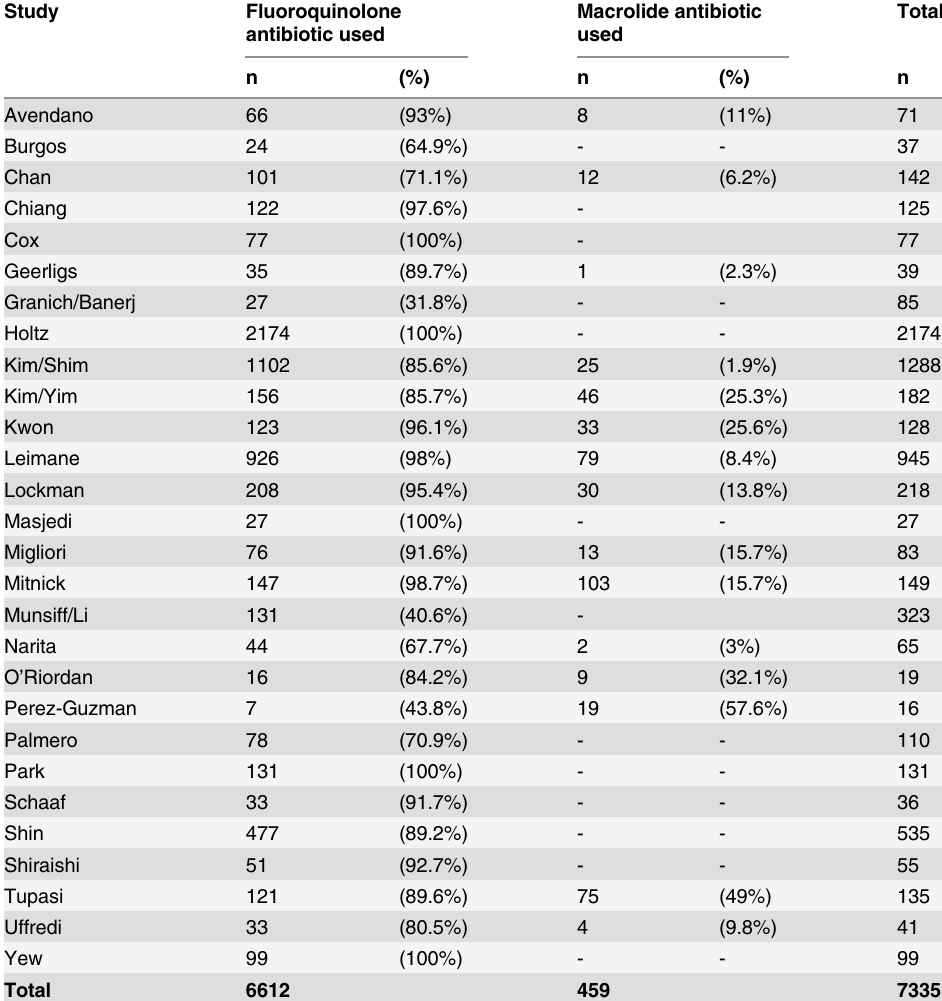
Table 9. Subjects by study, stratified by fluoroquinolone and macrolide